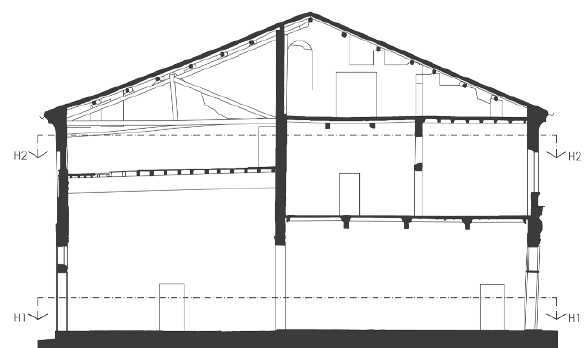
Figure 4: Vertical section V1 obtained from the points cloud (Municipality of Mantua).